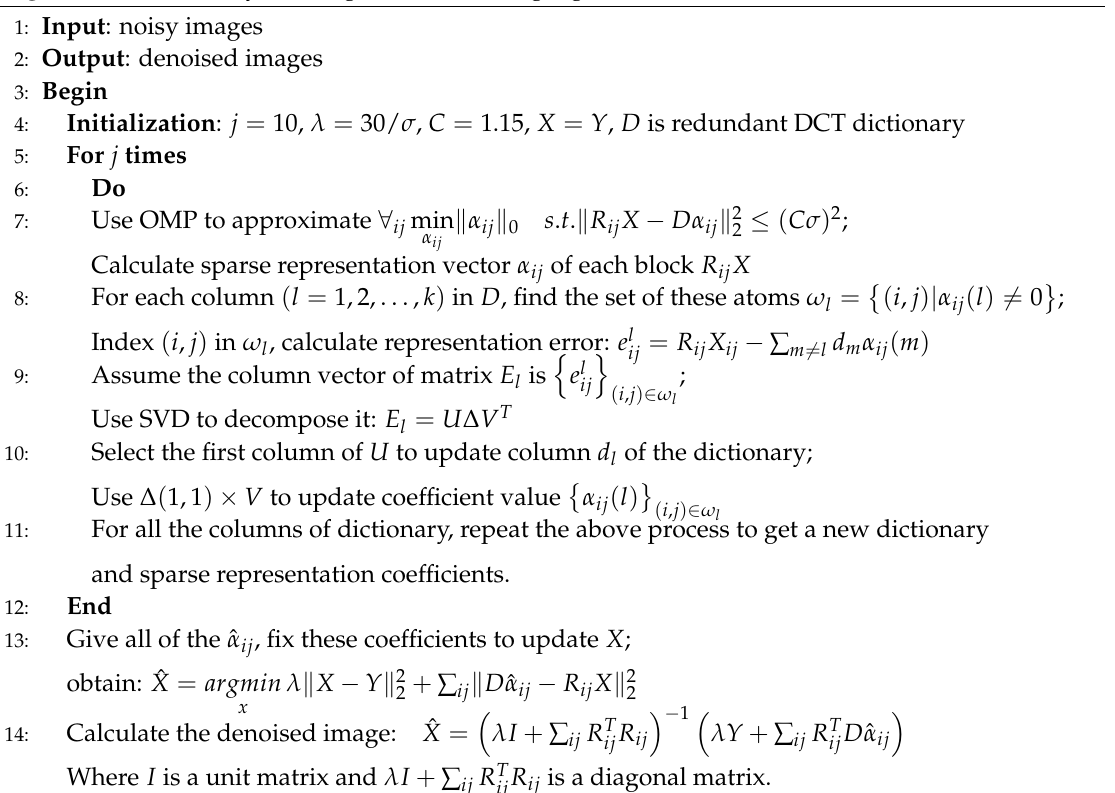
Algorithm 1 Dictionary learning-based denoising